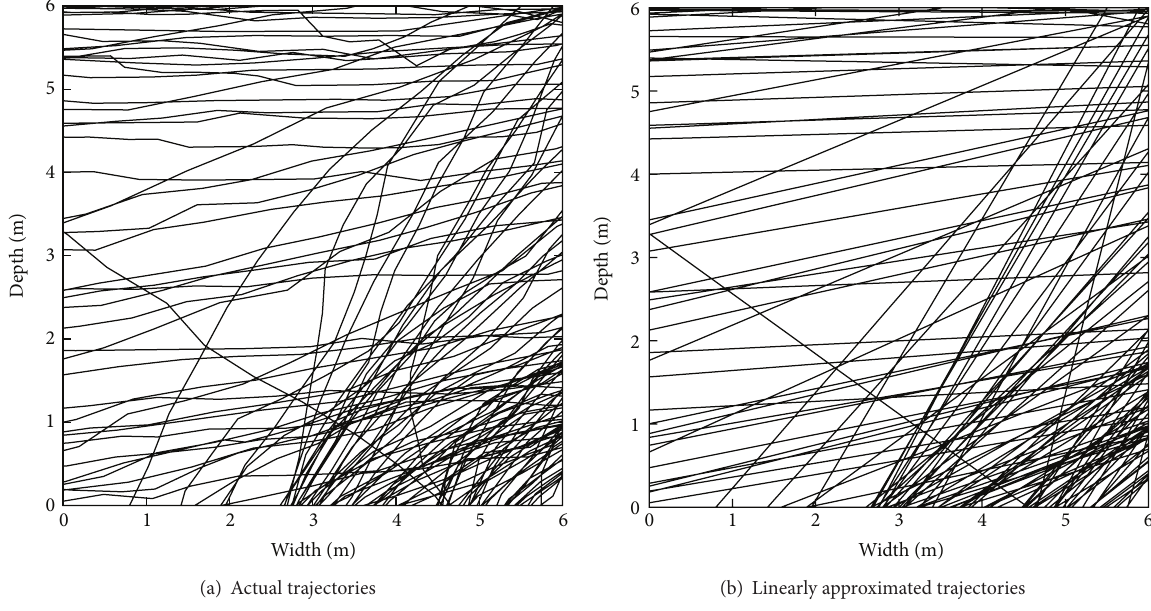
Figure 3: Actual and approximated pedestrian trajectories.